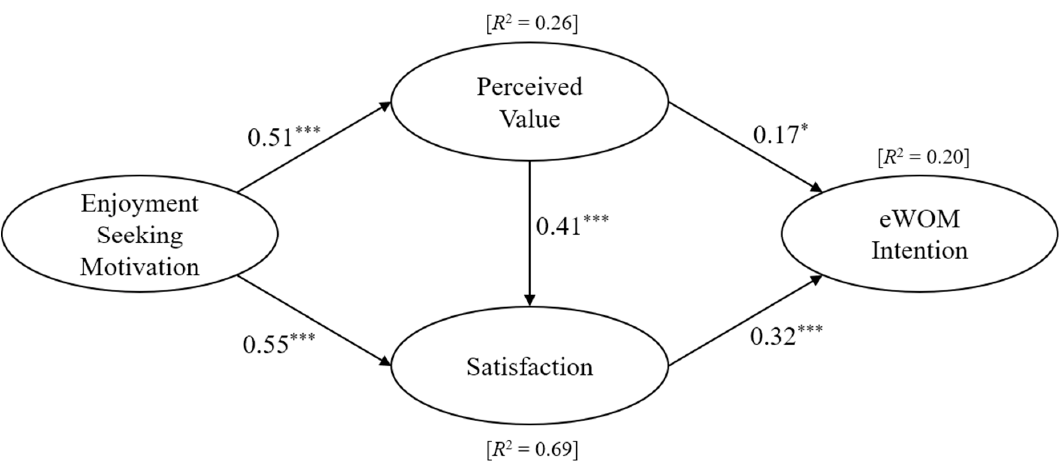
Figure 2. Overall results of the structural equation model. χ 2 (49) = 104.34, p < 0.001, χ 2 / df = 2.86, CFI = 0.97, TLI = 0.96, RMSEA = 0.07 (90% CI: 0.06–0.08), SRMR = 0.04. * p < 0.05, *** p < 0.001.